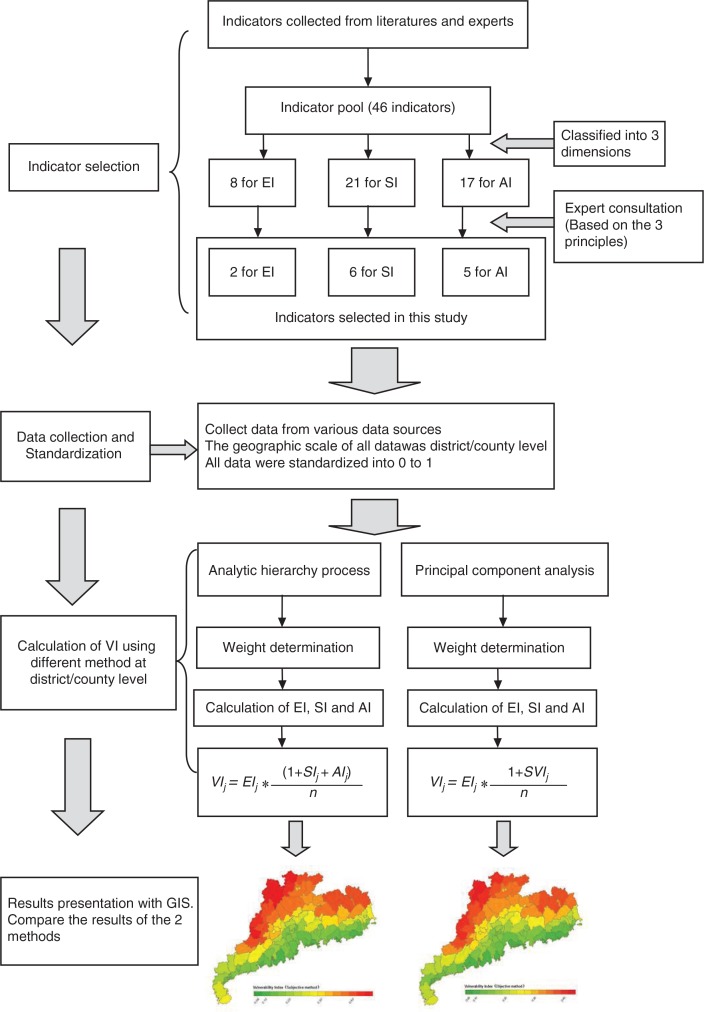
The flow diagram of the assessment process.